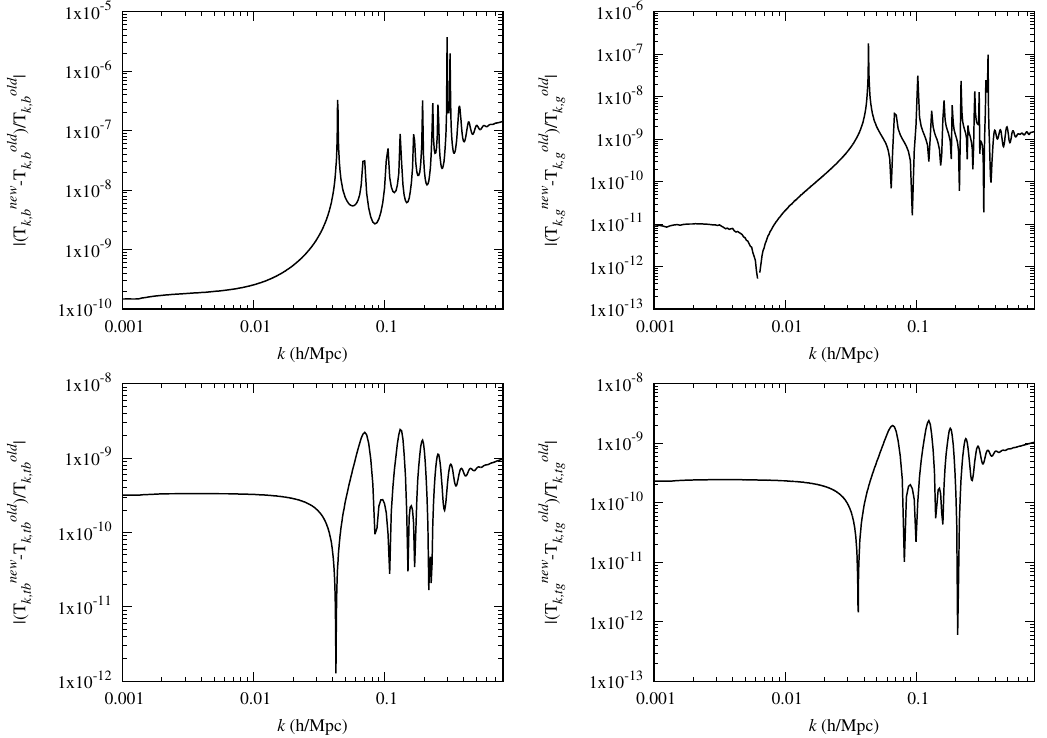
Figure 5. Relative difference in the transfer function for δ b , δ γ , θ b , and θ γ at z = 1000. The y -axis gives the relative error between covariant results and non-covariant results. The error increases at higher values of k and reaches values of order 10 − 6 10 − 5 for δ b ∼